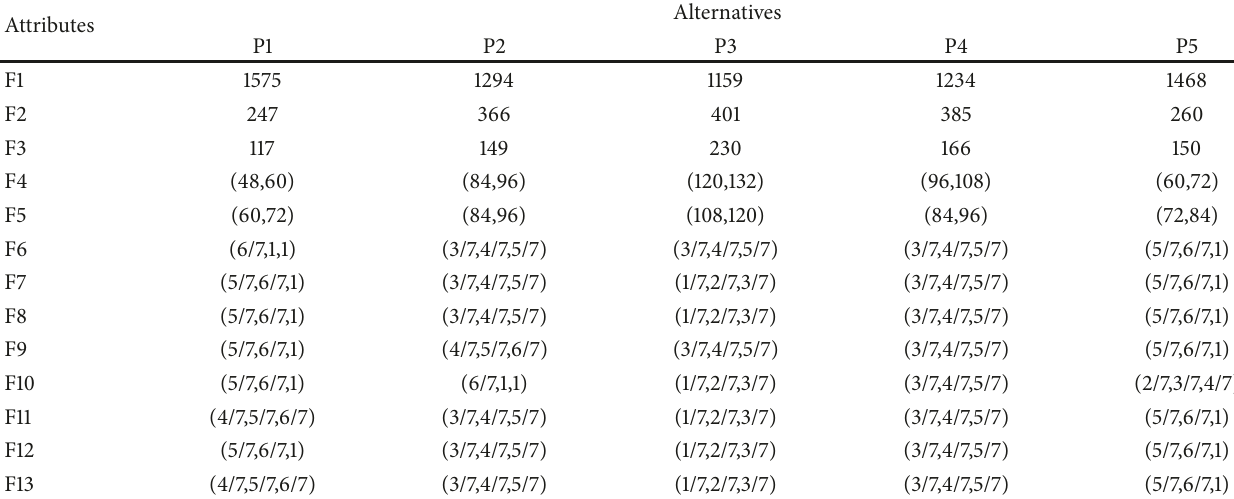
Table 2: Online channel, attribute evaluation